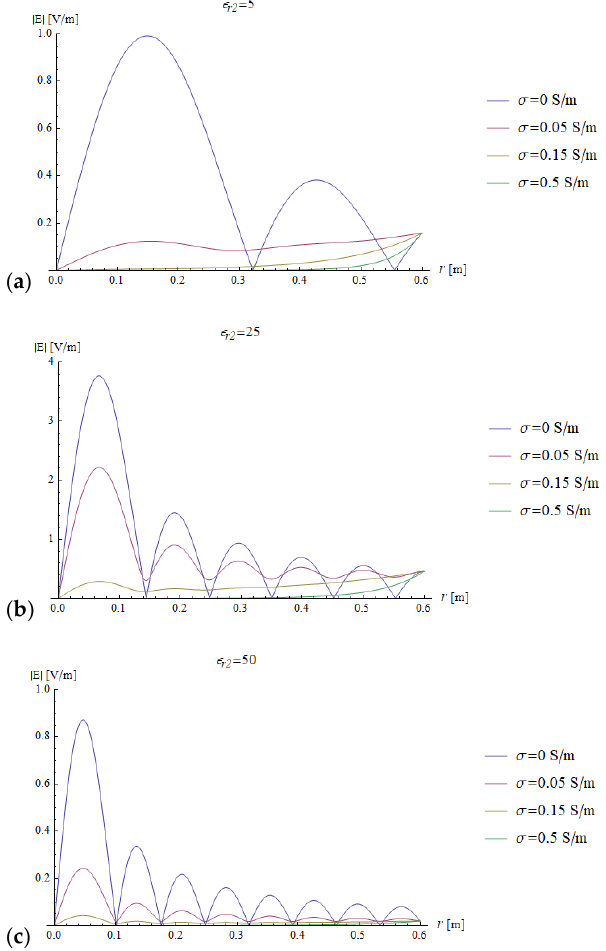
Figure 7. The amplitude of the electric field inside a sphere of radius a = 0.6 is plotted as a function of the radial coordinate r for different values of relative permittivity ( ε r 2 = 5, 25 and 50 in ( a – c ), respectively) and conductivity (see plot legend).